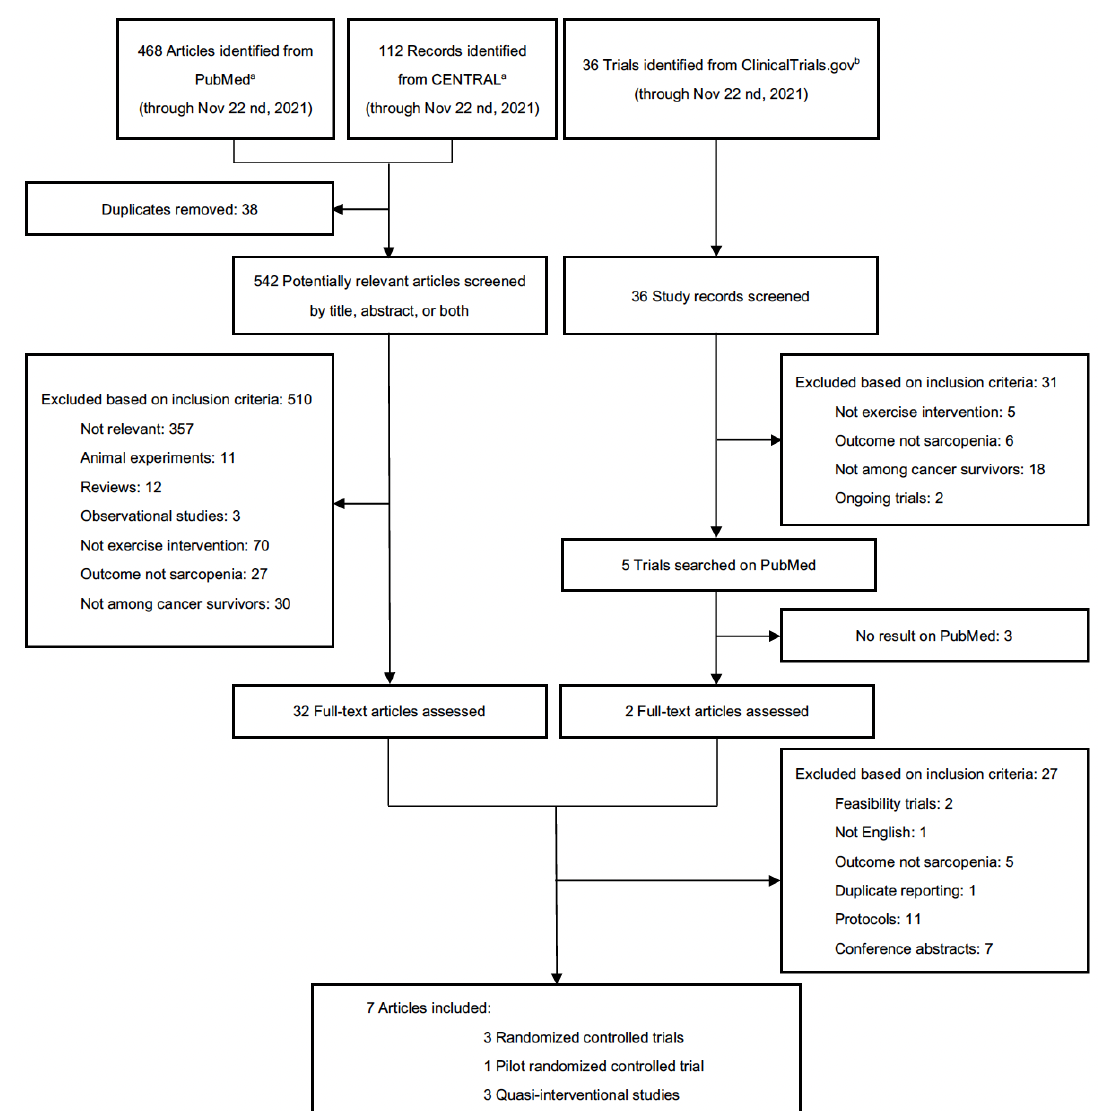
Figure 1. Selection process of included studies. a PubMed and CENTRAL (Cochrane Central Register of Controlled Trials) search terms: ((exercise) OR (exercises) OR (physical activity) OR (physical activities)) AND ((sarcopenia) OR (sarcopenic obesity)) AND ((cancer) OR (neoplas*) OR (tumor)). b ClinicalTrials.gov search terms: Condition or Disease: (sarcopenia) OR (sarcopenic obesity); Intervention/treatment: (exercise) OR (exercises) OR (physical activity) OR (physical activities); Other terms: (cancer) OR (neoplas*) OR (tumor); Study type: Interventional studies (Clinical Trials).